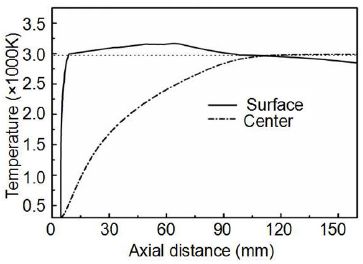
Figure 6. Surface and center temperature of a single agglomerated YSZ particle during the plasma process.